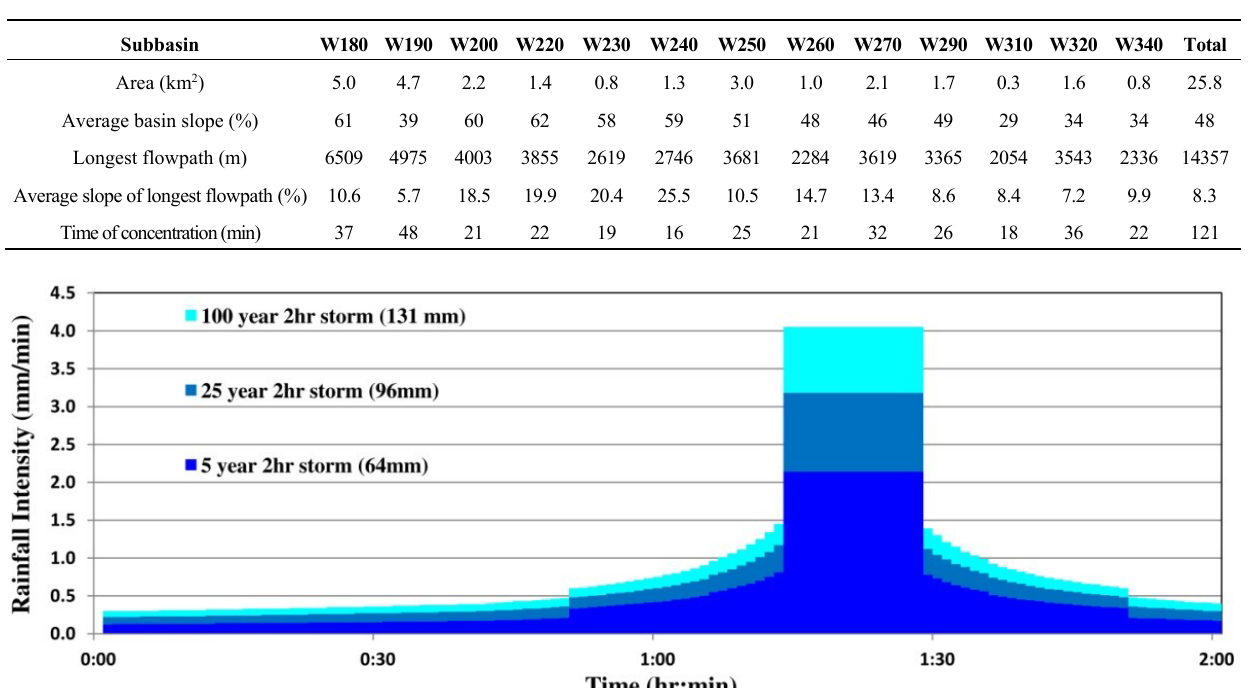
Table 1. Overview of subbasin features.